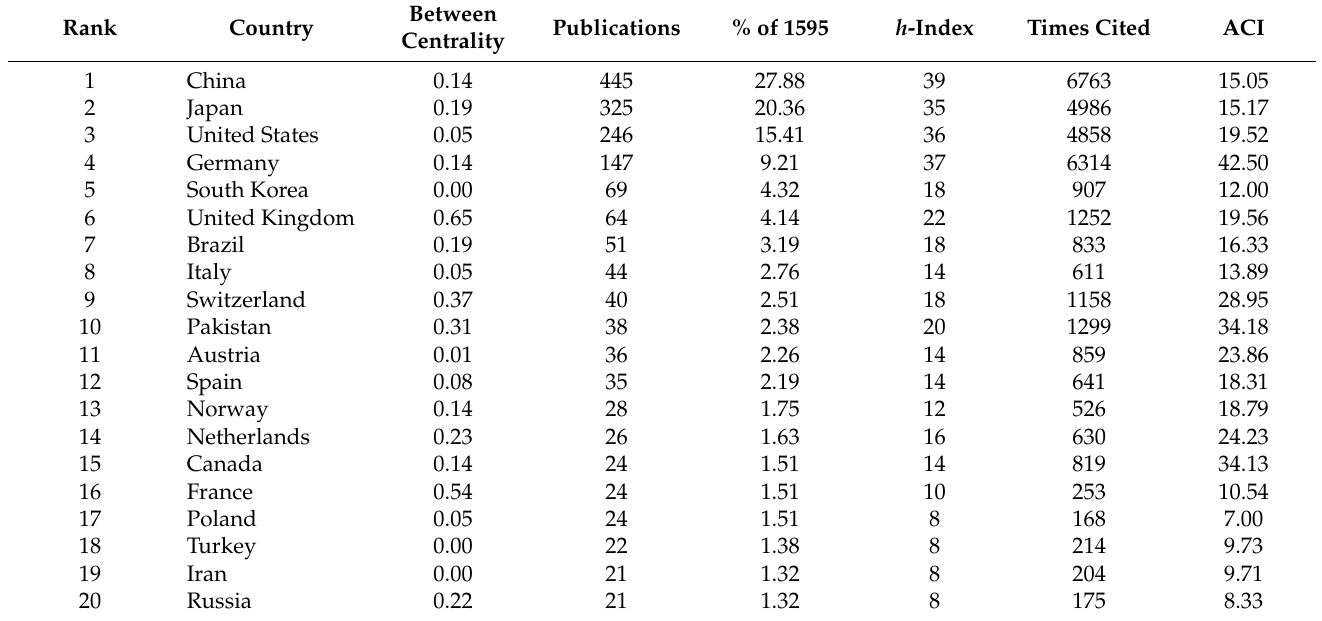
Table 1. The information of the top-20 countries according to the publication analysis in 5-ALA